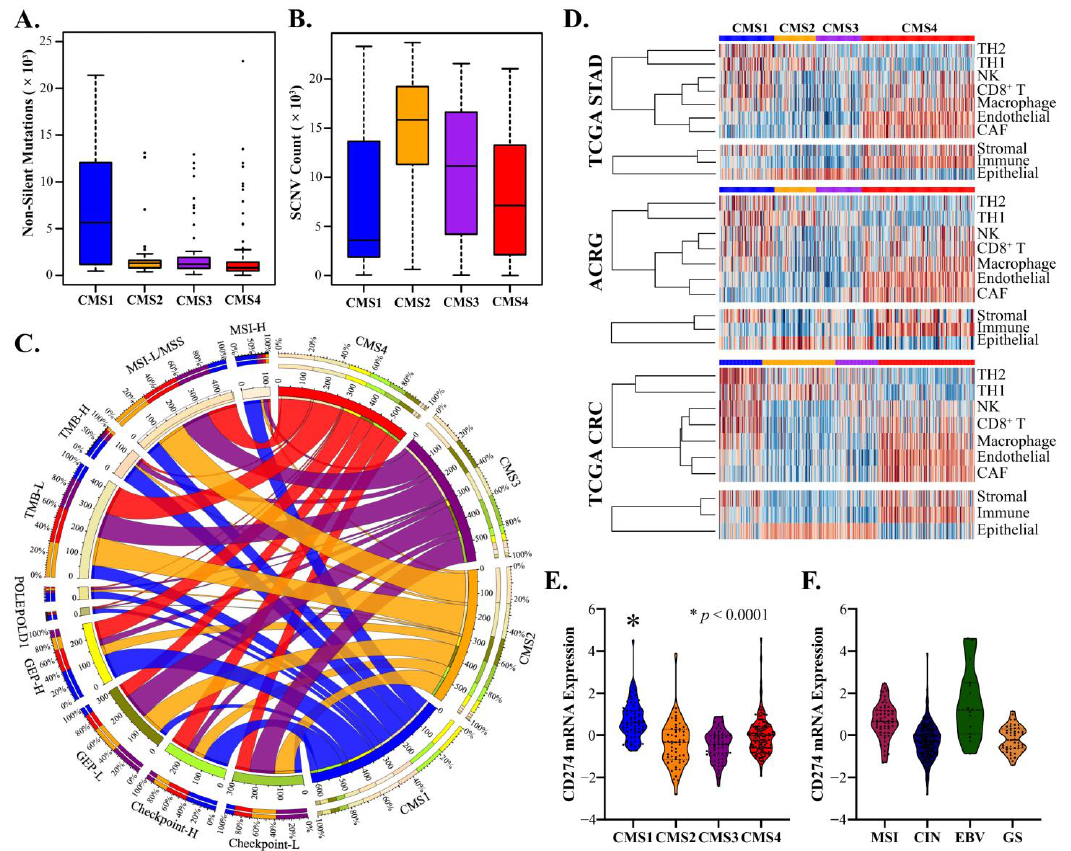
Figure 3. CMS1 classification is linked to immunotherapy susceptibility markers in GAC. ( A , B ). CMS1 demonstrated hypermutation compared to CMS2, CMS3, or CMS4 ( p < 0.0001 for all comparisons), as well low somatic copy variation (SCNV) consistent with CMS1 in CRC. ( C ). Circos diagram demonstrating strong contingency between CMS1 in GAC and clinical markers of immunotherapy response: MSI-H, TMB, GEP, POLE/POLD1, and checkpoint. ( D ). Tumor microenvironment and immune markers from the TIMER/Cistrome and ESTIMATE projects relative to GAC CMS type, demonstrating enrichment of CD8+ T cells, NK cells, and Th cells in CMS1 and enrichment of stroma, endothelia, CAF, and macrophage markers in CMS4. ( E , F ). Violin plot demonstrating enriched expression of CD274 (PD-L1) in CMS1 compared to CMS2-4 ( p < 0.0001 for all comparisons), with increased association compared to standard clinical subtypes of GAC.